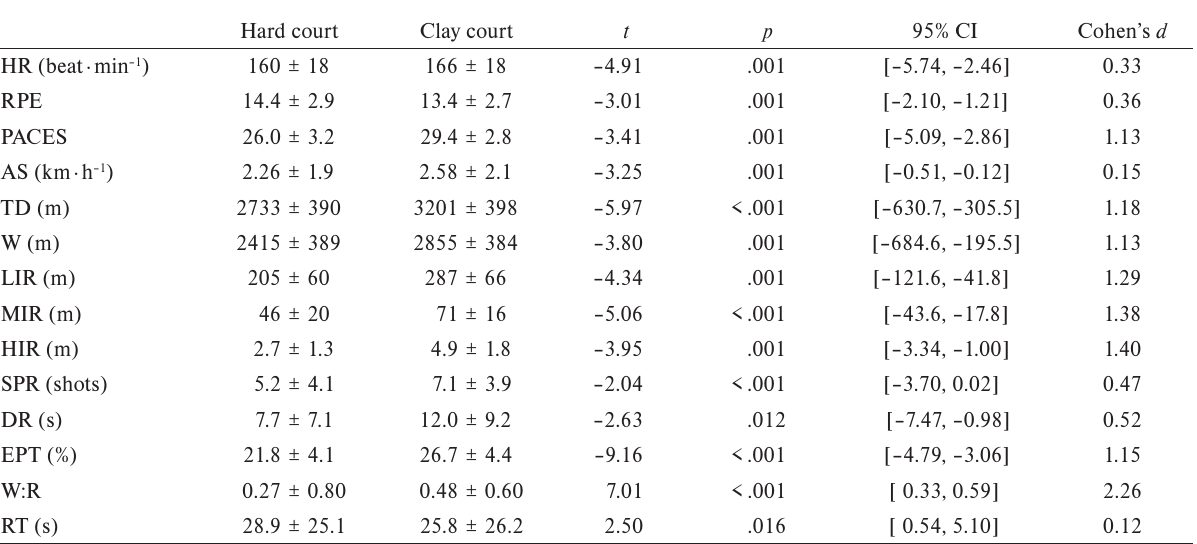
Table 1 Simulated tennis matches analysis